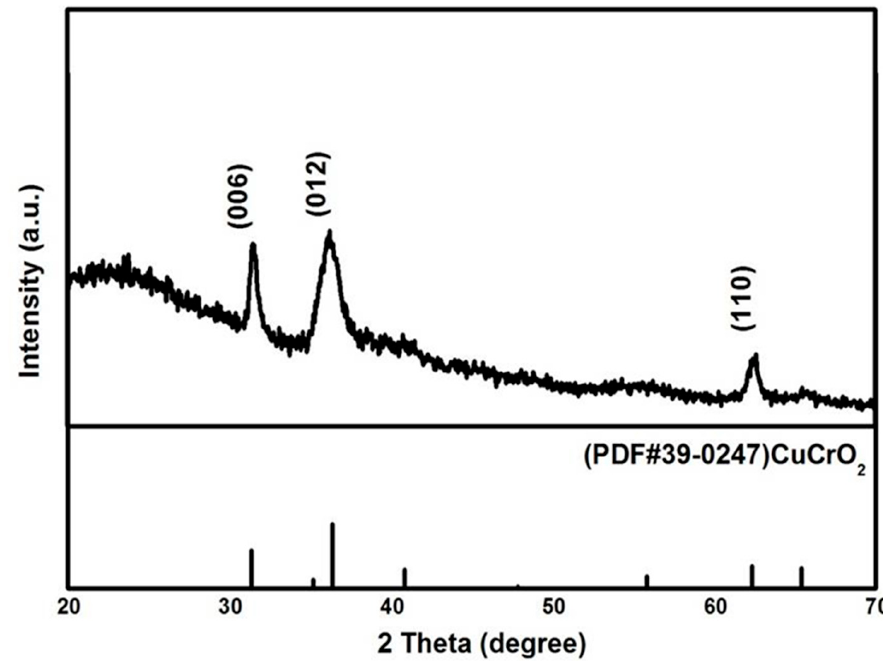
Figure 2. XRD pattern of CuCrO 2 nanowire deposited by electrospinning at 3000 rpm rotating speed on the glass substrate after annealing at 600 °C.